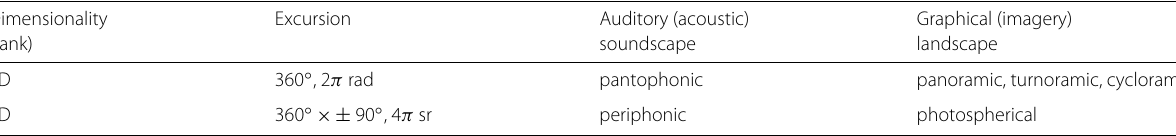
Table 3 Surround displays